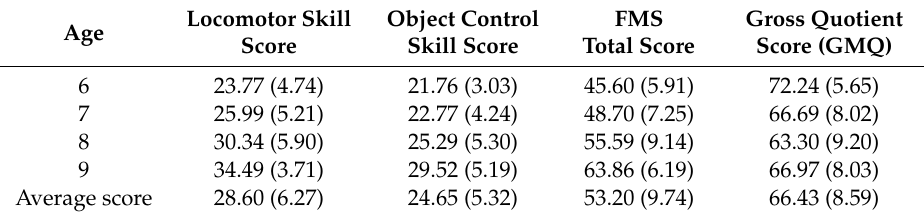
Table 2. Participant’s FMS performance at baseline by age ( n =